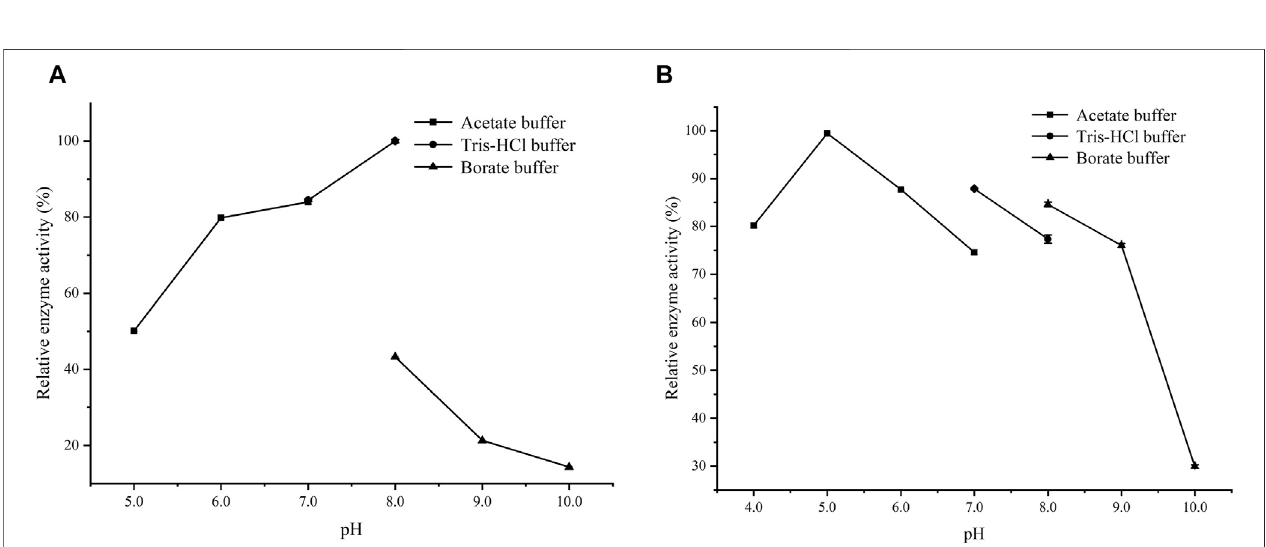
FIGURE 2 | Effect of pH on the activity of Lsa AS-A. (A) Optimal pH of Lsa AS-A. (B) Stability of Lsa AS-A at different pH buffer solution.